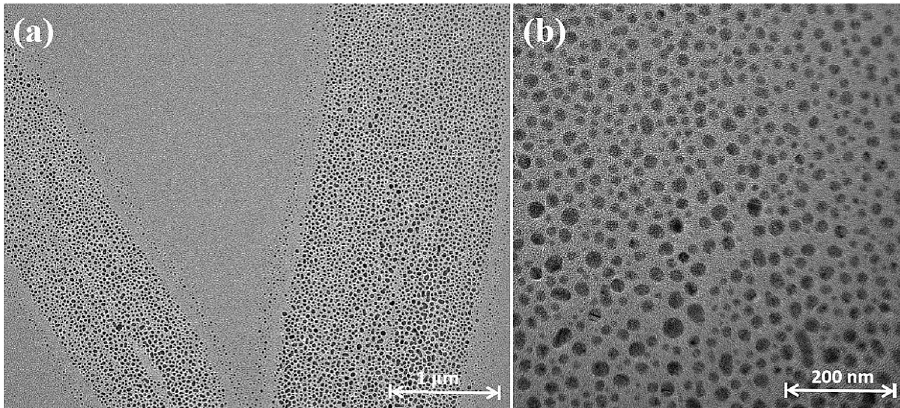
Figure 3. HRTEM images of Ag 2 O NPs (60 °C/10 min) with ( a ) 1 μm scale ( b ) and 200 nm